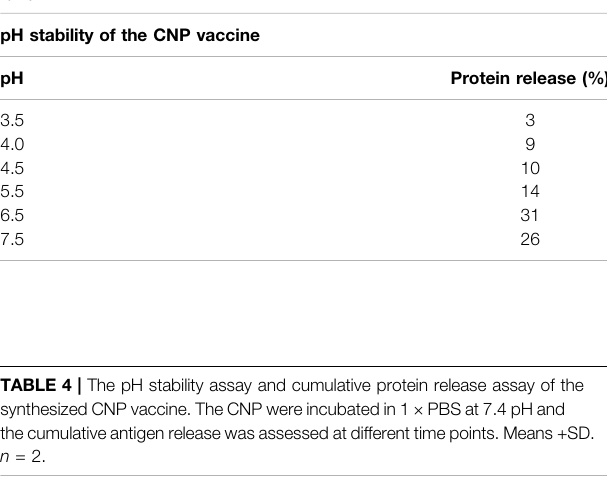
TABLE 5| EffectofCNP onchickenred blood cells. TheCNP wassynthesized by entrapping a crude-enriched extract of OMP and Flagellin proteins from Salmonella enterica serovar Enteritidis. Mean ± SD. n =